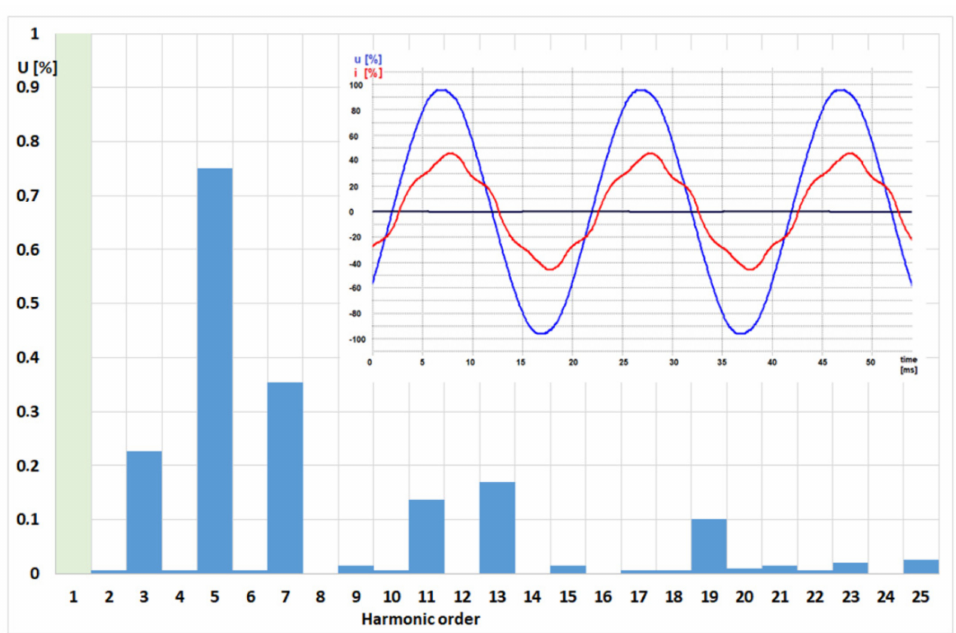
Figure 5. Spectrum of voltage harmonics and voltage and current waveforms recorded at point A. The distorted current of the substation causes voltage distortion on both the primary and secondary sides of the MSP energy transformer. Spectrum of current harmonics and current waveform recorded at point A shows Figure 6.